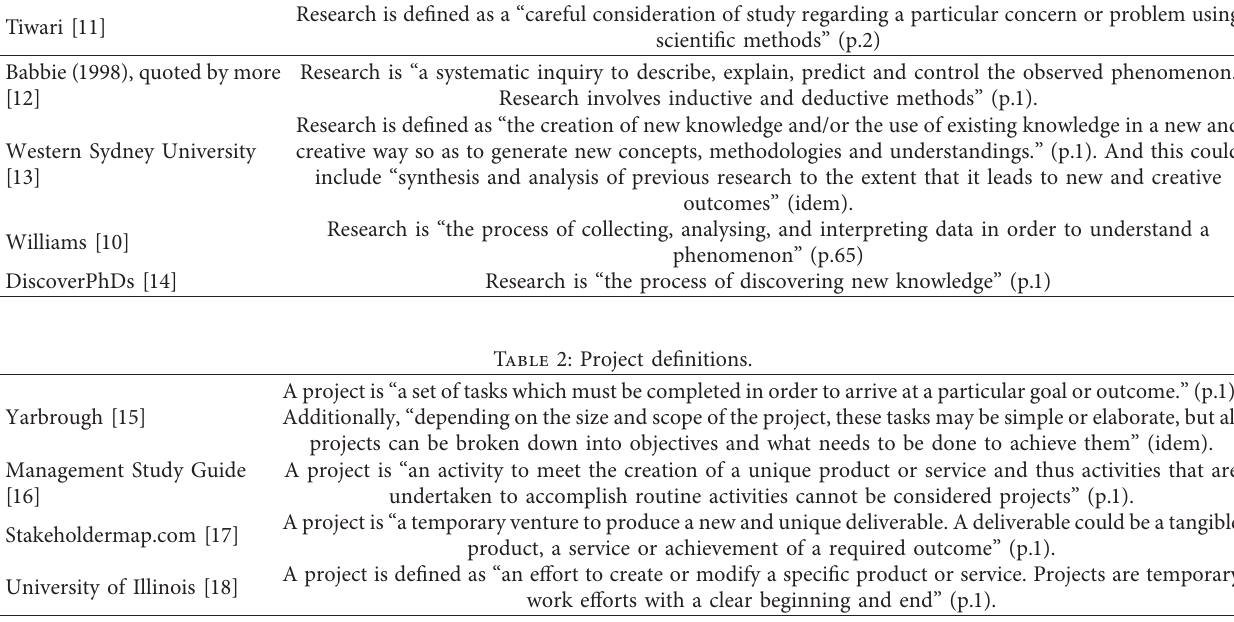
Table 1: Research